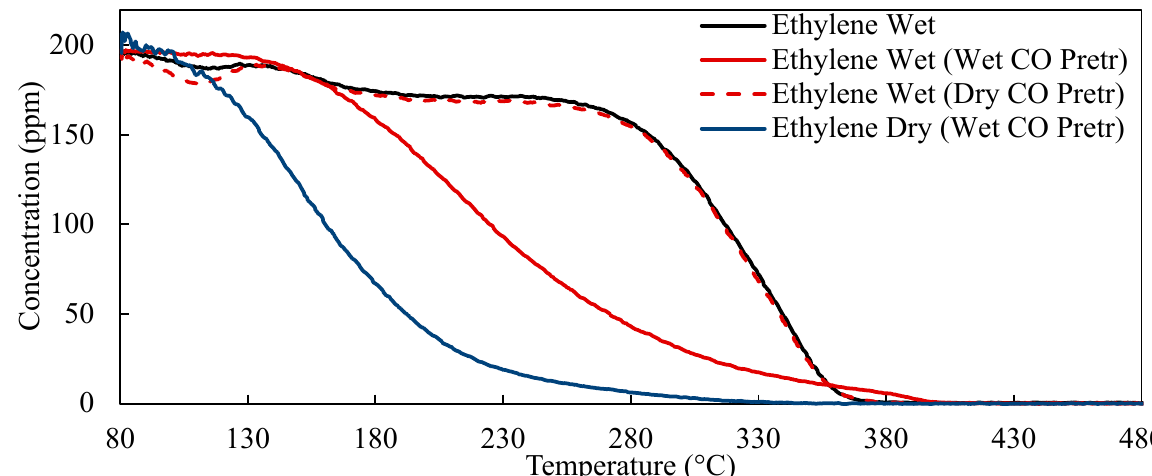
Figure 6. Ethylene conversion during temperature ramp after wet and dry CO pretreatment. (Pretreatment: 500 ppm CO, 0 or 6% H 2 O, 12% O 2 , balance N 2 ) (Adsorption and TPO: 200 ppm ethylene, 0 or 500 ppm CO, 0 or 6% H 2 O, 12% O 2 , balance N 2 ).